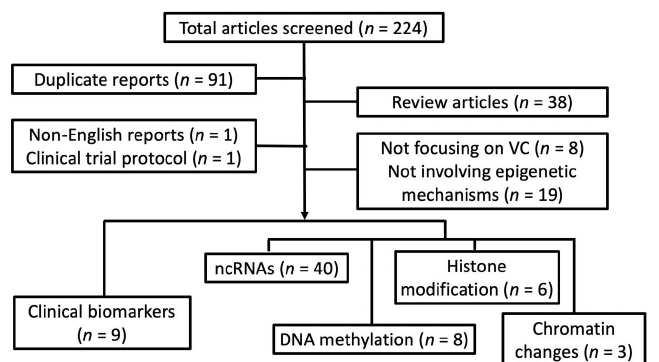
Figure 1. A flow chart detailing our systematic review strategy and the derivation of included reports. ncRNA, non-coding RNA; VC, vascular calcification.